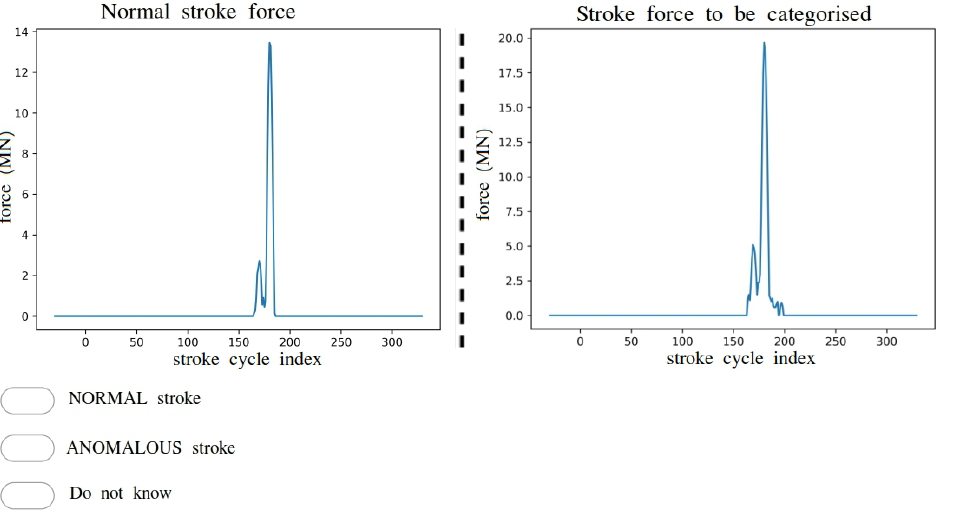
Figure 3. A sample of stroke question in the questionnaire for domain